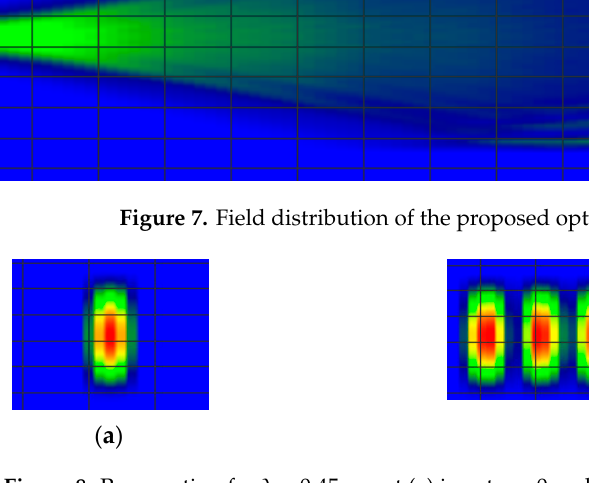
Figure 8. Propagation for λ = 0.4 5 µm at ( a ) input z = 0 and ( b ) output ports z = 1480 µm